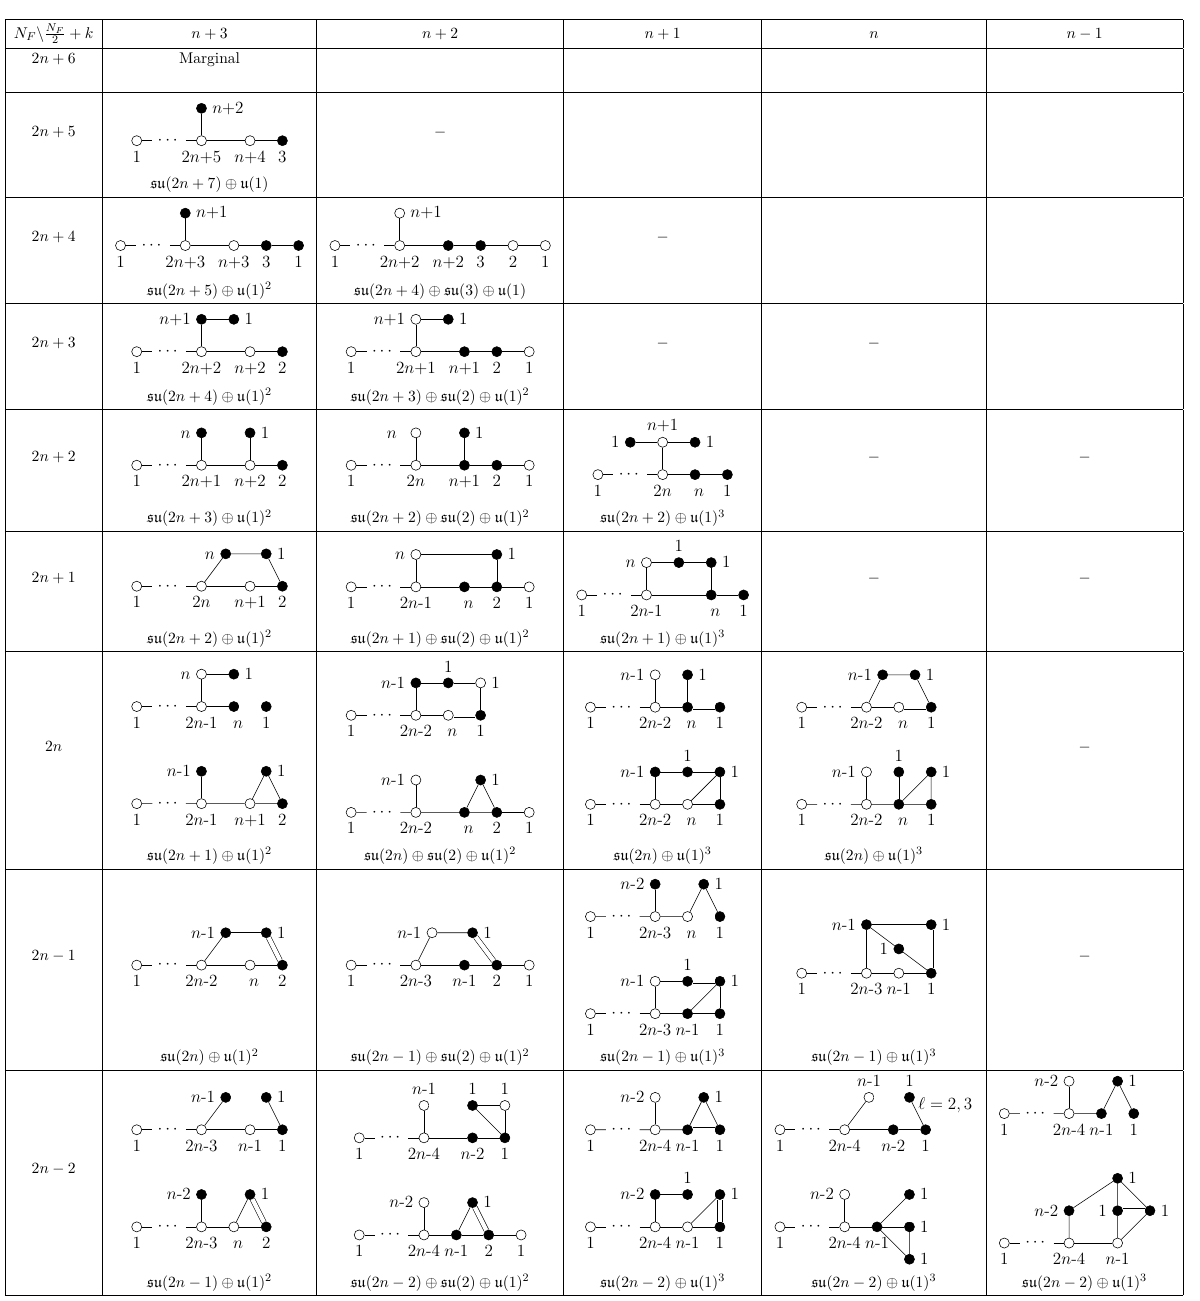
Table 15 . UV-MQs for descendants of SU(2 n ) 0 + 1 AS + (2 n + 6) F with N F ≥ (2 n − 2)